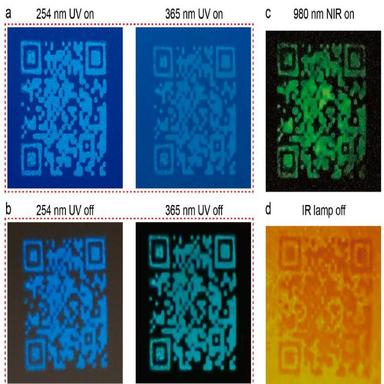
Photographs of the prepared QR code under different encryption modes: a) fluorescence encryption with 254-nm light on (left panel) and 365-nm light on (right panel), b) phosphorescence encryption with 254-nm light off (left panel) and 365-nm off (left panel), c) up-conversion fluorescence encryption with 980-nm laser excitation, and d) infrared thermal images after IR lamp off.